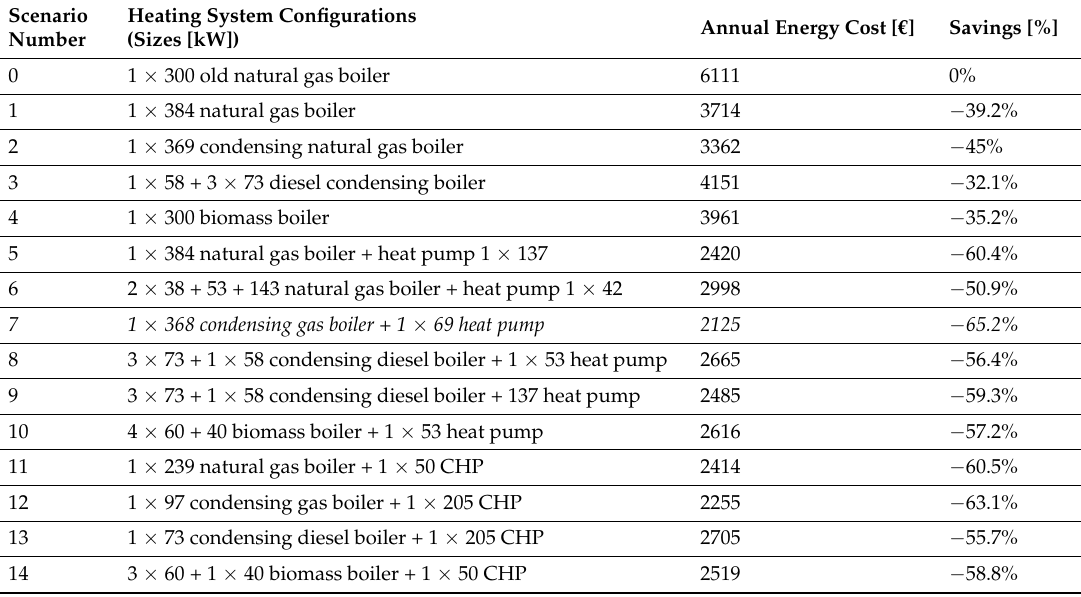
Table 4. Comparison of heating systems’ annual energy